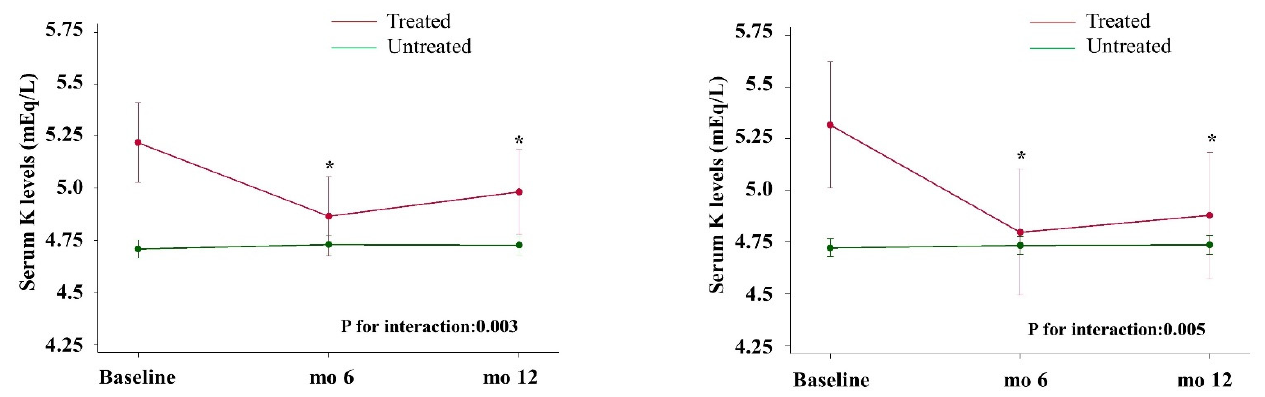
Figure 3. Treatment-by-time interaction between serum potassium levels in patients treated and not treated with bicarbonate supplements (left) and potassium-binders (right). * p < 0.05 vs. baseline.